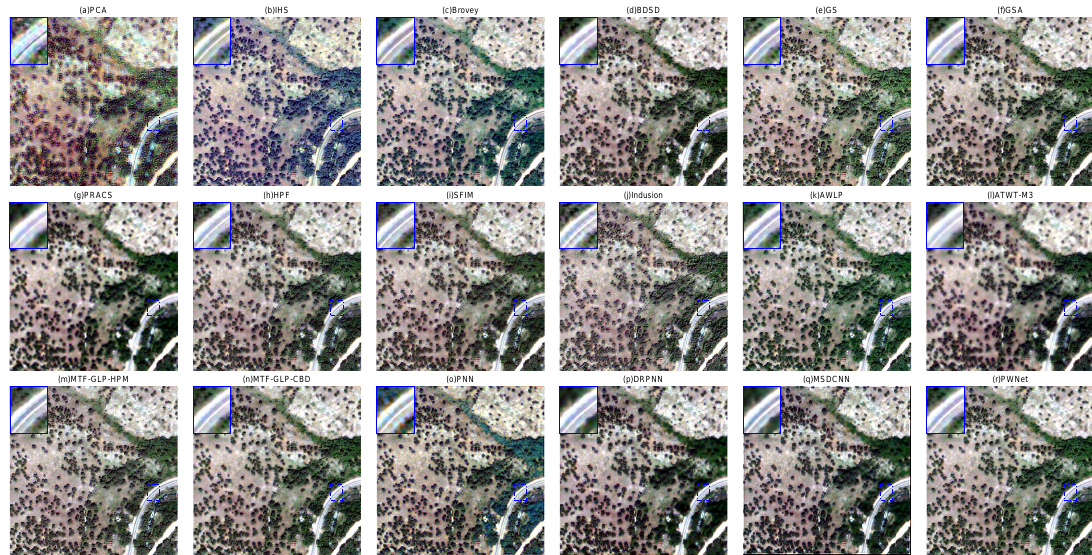
Figure 16. Visual comparison of different methods on the QuickBird data set at full resolution,